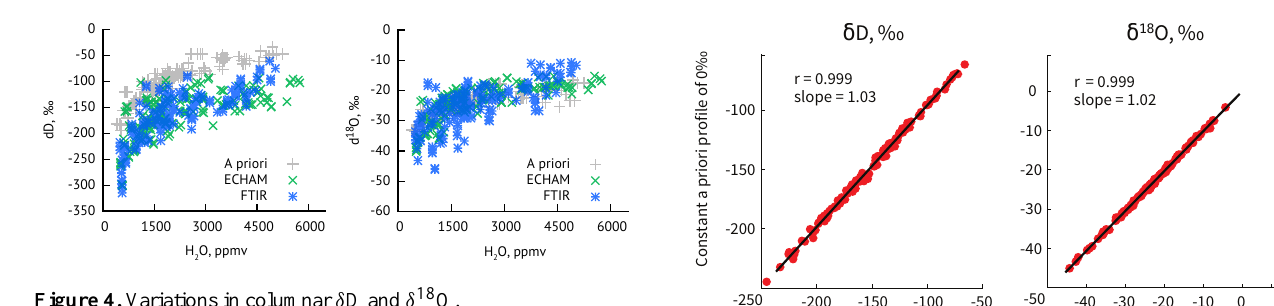
Figure 4. Variations in columnar δ D and δ 18 O.